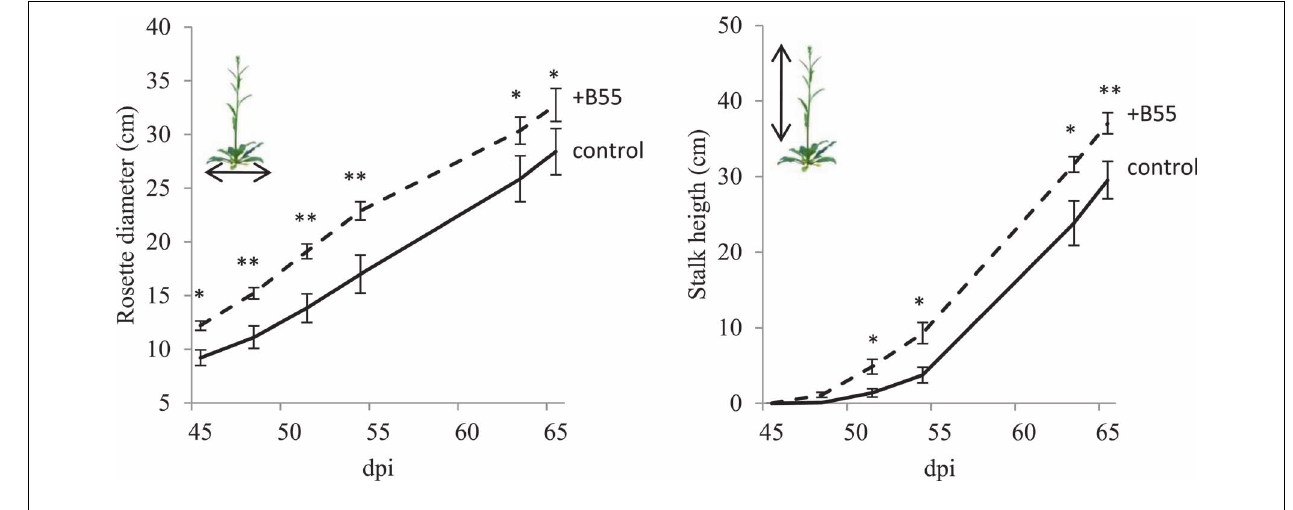
until the end of the experiment were included in the analysis. Asterisk indicates a statistically significant difference between treatments as determined by a paired t -test (* P < 0.05 ; ** P < 0.01 ). dpi, days post infection. n = 11 pairs.